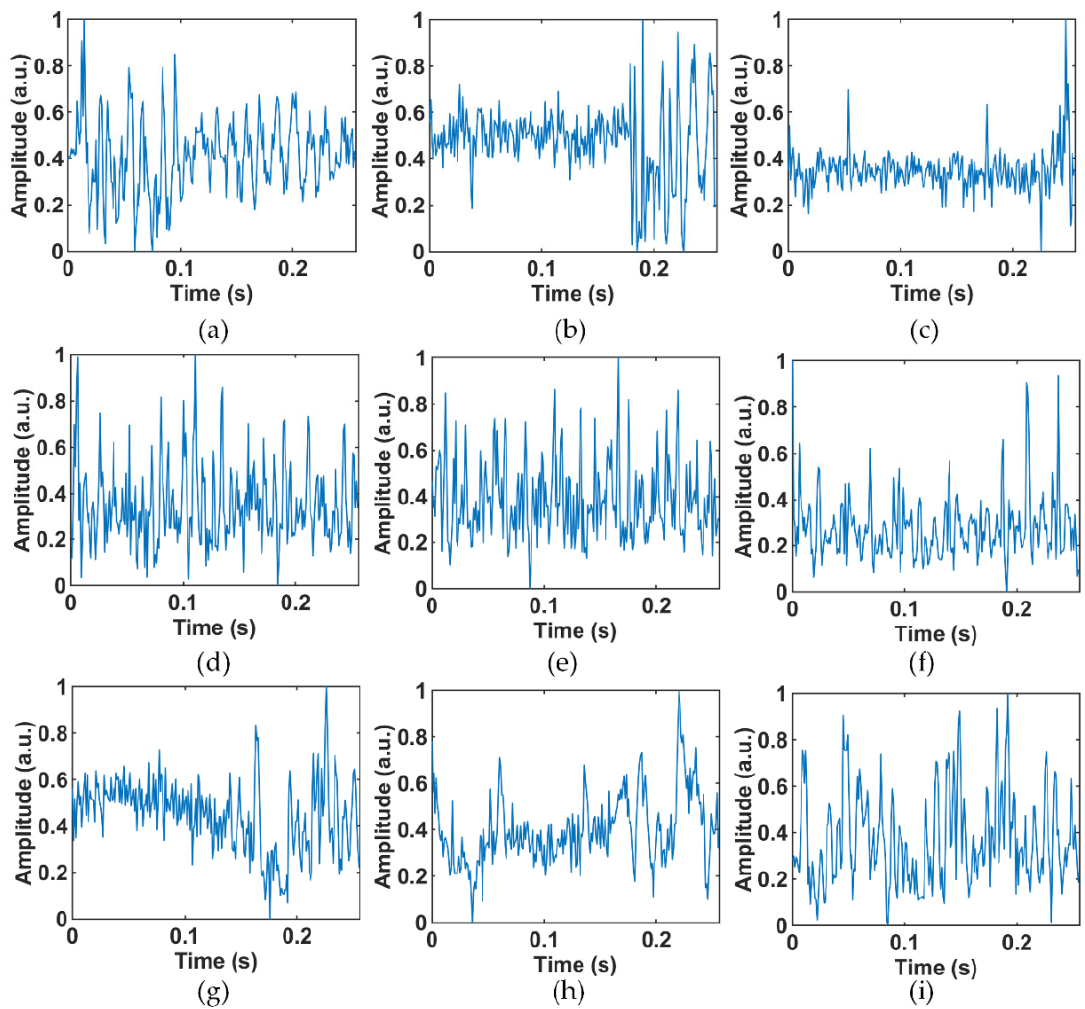
Figure 6. Other samples in the time-domain dataset: ( a – c ) hammer; ( d – f ) air pick; and ( g – i )